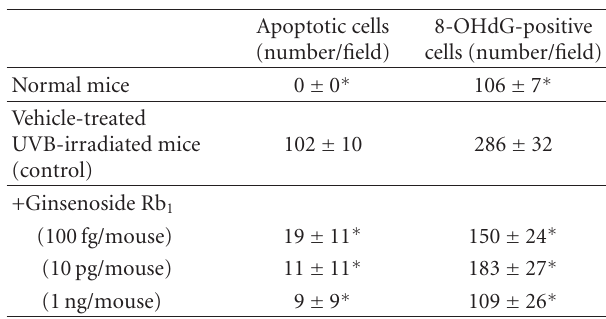
Table 5: E ff ects of ginsenoside Rb 1 on the numbers of apoptotic and 8-OHdG-positive cells at week 12 in the skin of UVB-irradiated hairless mice